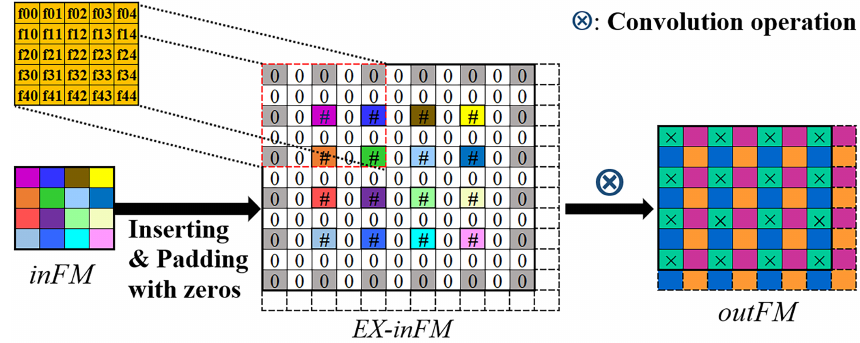
Figure 3. An illustration of the data transformation flow through inserting and padding with